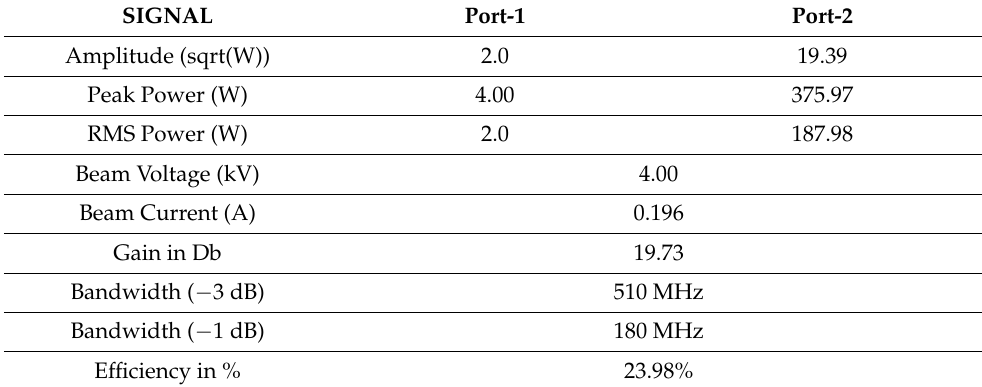
Table 6. Results of proposed multiple beam